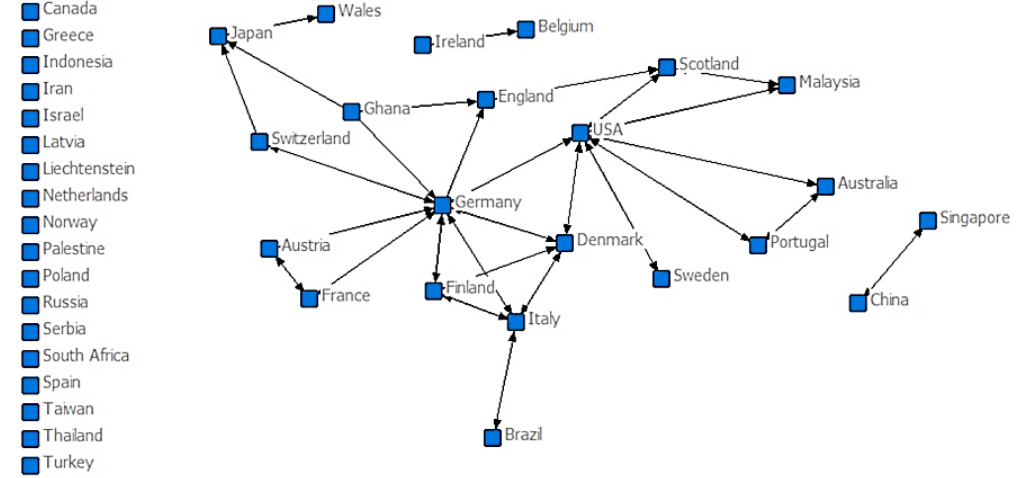
Figure 6. Network analysis of collaboration between authors (source: own study).